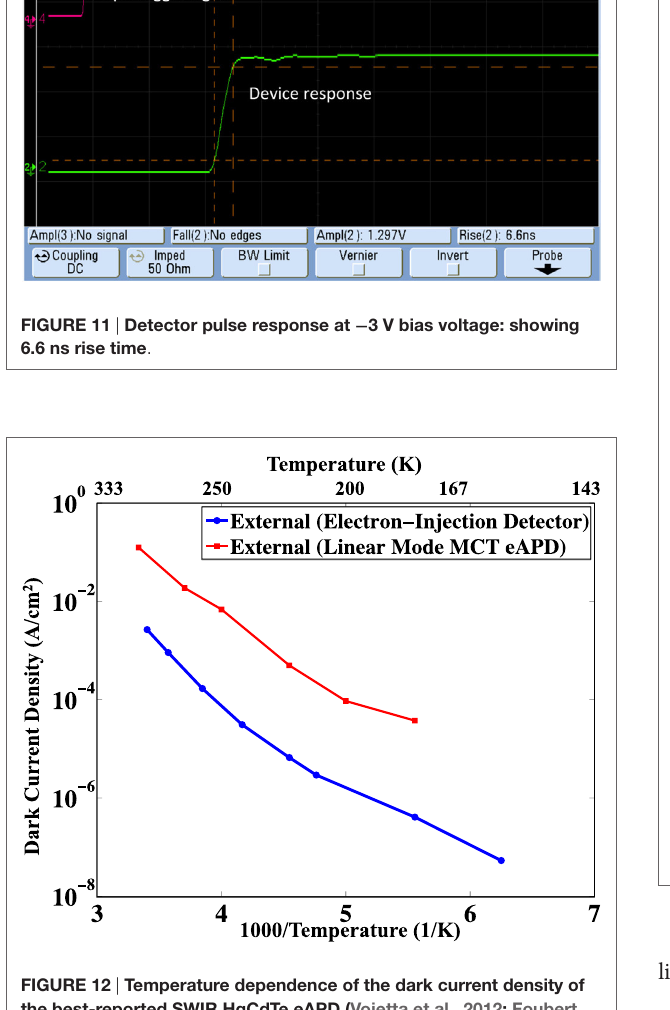
FiGURe 12 | Temperature dependence of the dark current density of the best-reported SwiR HgCdTe eAPD (vojetta et al., 2012; Foubert et al., 2013) and the electron-injection detector: electron-injection detector has more than an order of magnitude lower dark current density (Fathipour et al., 2014b) .